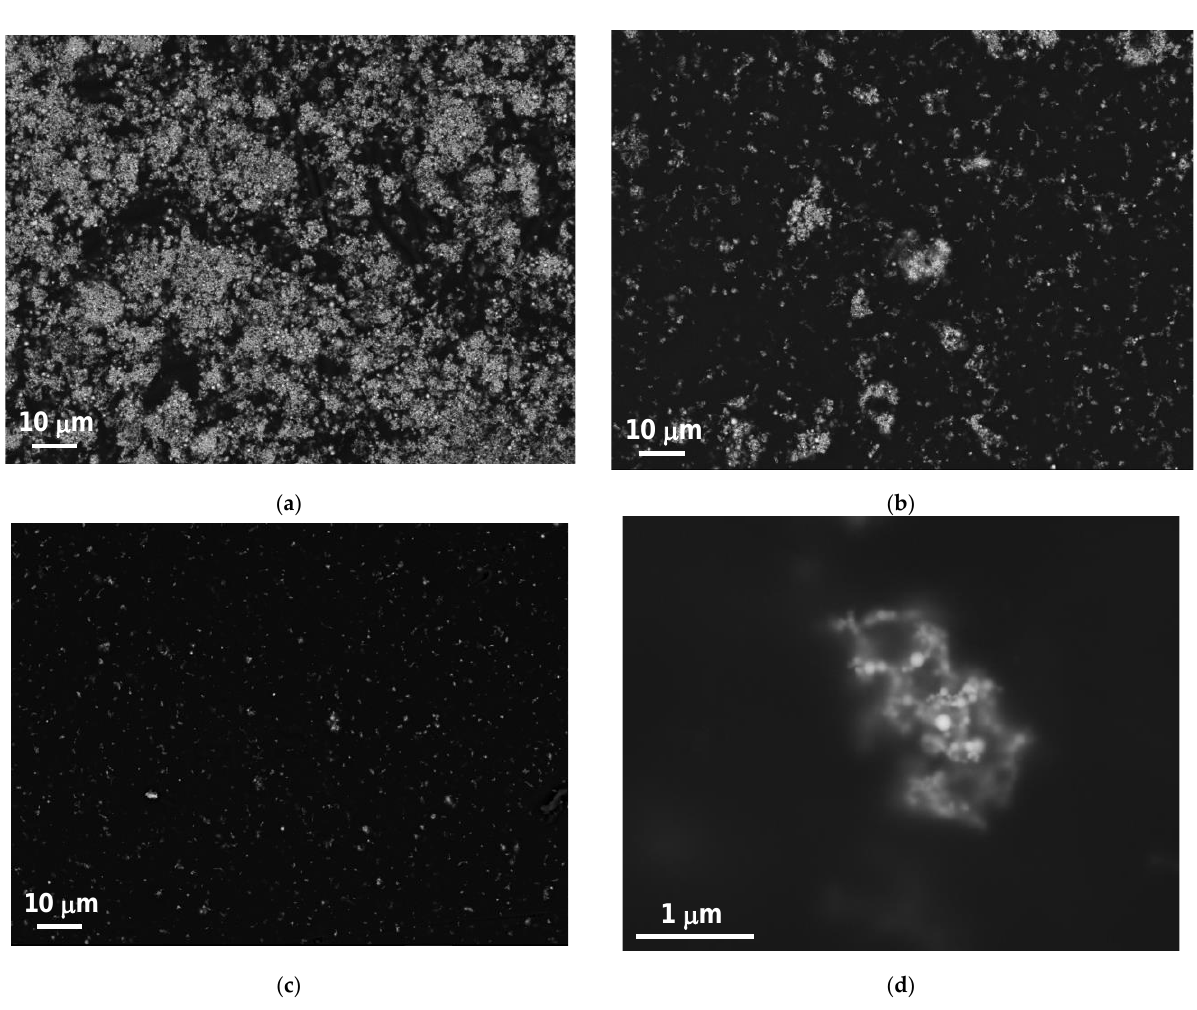
Figure 5. Surface properties of GE/Ni composites evaluated using scanning electron microscopy: ( a ) Ge/69 wt.% of Ni; ( b ) GE/31 wt.% of Ni; ( c , d ) GE/10 wt.% of Ni.